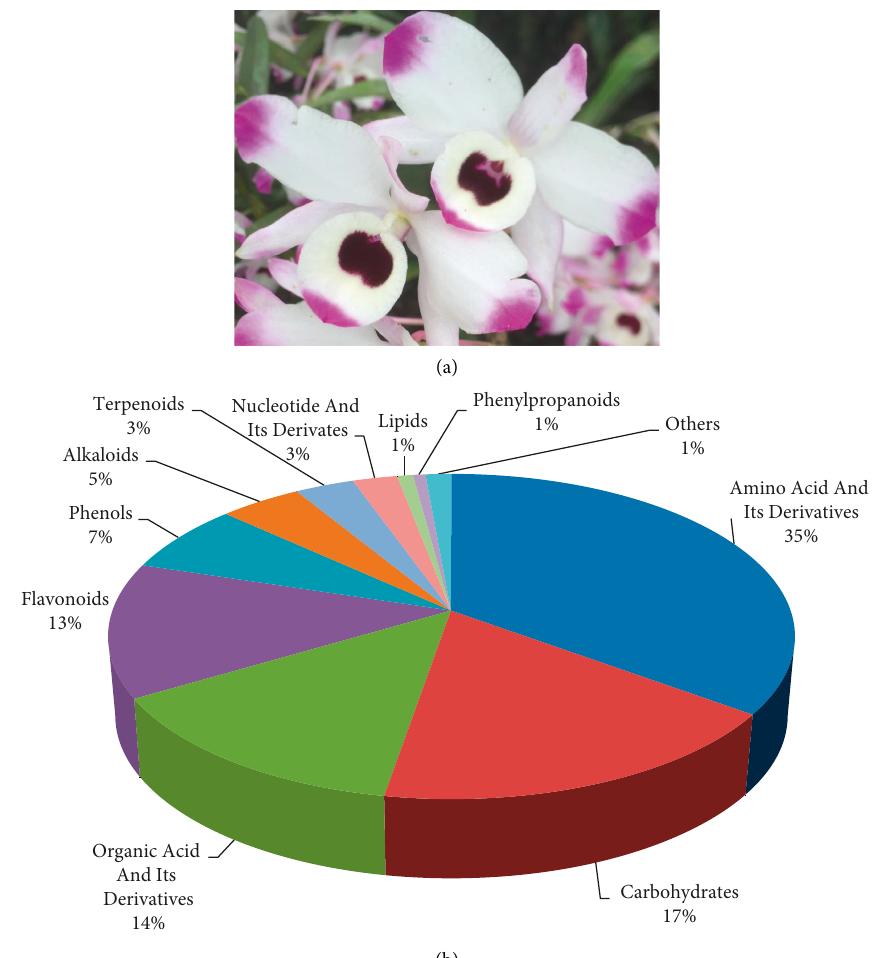
Figure 3: Distribution of the detected metabolites in flower of D. nobile . (a) Flower of D. nobile . (b) The detected metabolites were classified into 11 kinds of chemical compounds ( n �